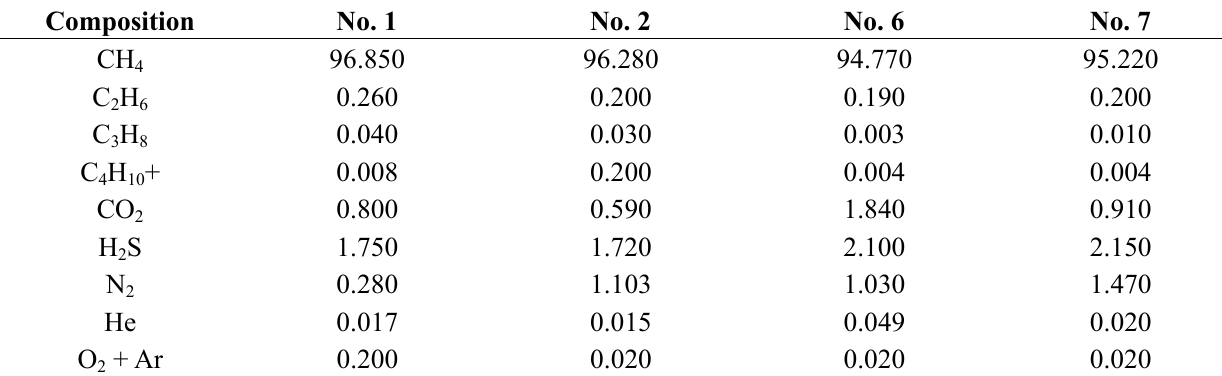
Table 4. The gas composition of pipelines No. 1, No. 2, No. 6 and No. 7.